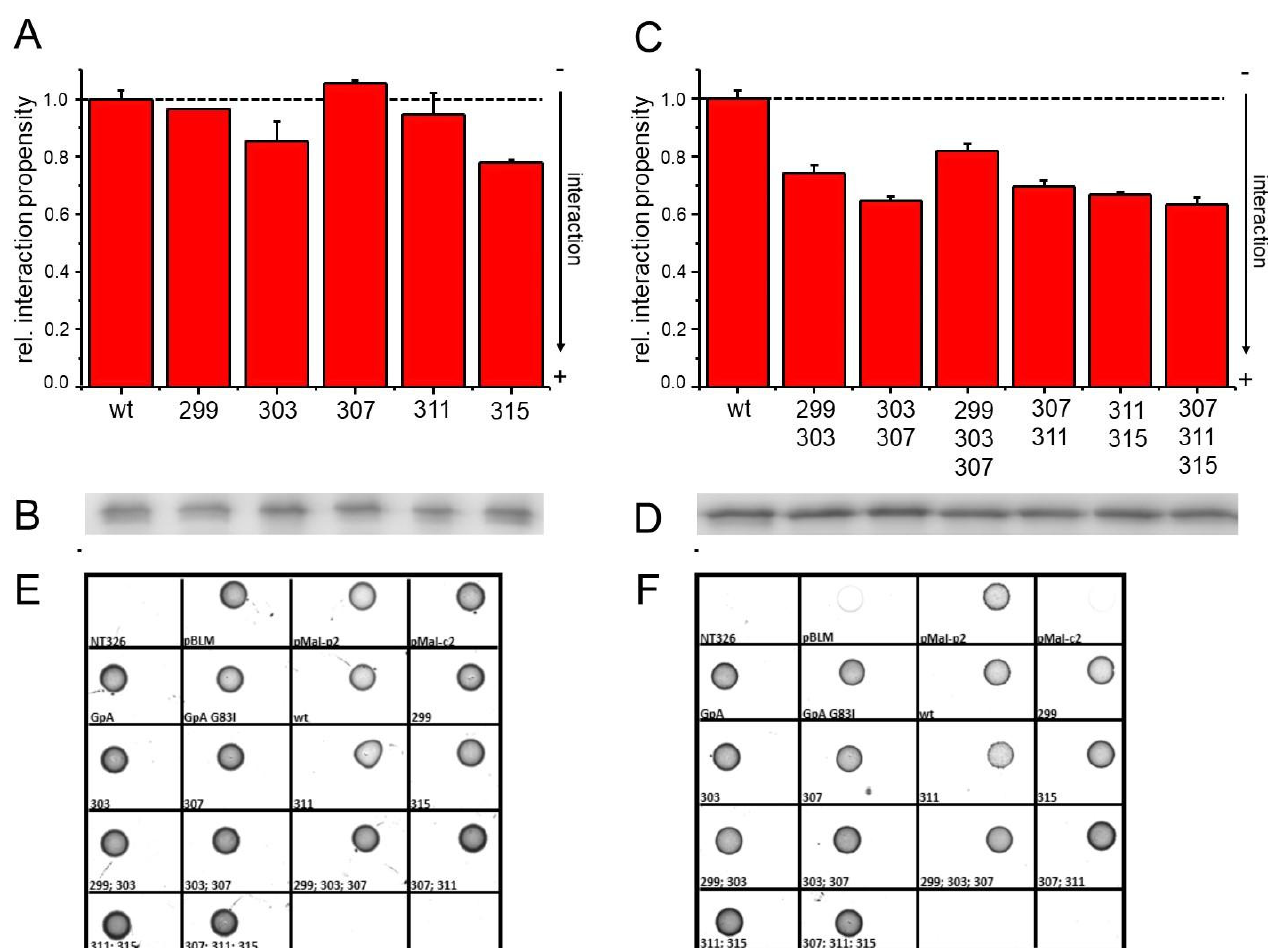
Figure 2. GALLEX measurements of the human CA XII TM domain mutants. ( A ) Interaction tendencies of CA XII TM variants carrying mutations of individual small amino acids to Ile. The position of the mutated amino acid is indicated below each bar. All interaction propensities have been normalized to the wt (set as 1.0). The interaction propensities are an average of three independent measurements, and the standard deviation is shown. ( B ) Identical amounts of isolated total membrane proteins of cells analyzed in ( A ) were separated via SDS-PAGE, and the expressed amount of the CA XII TM fusion protein was analyzed via Western blot analyses using an antibody directed against the MalE protein. All analyzed proteins were expressed at similar levels in membranes. ( C ) GALLEX measurement of CA XII variants carrying mutations of multiple small amino acids to Ile. All interaction propensities have been normalized to the wt (set as 1.0). The interaction propensities are an average of three independent measurements, and the standard deviation is shown. ( D ) Identical amounts of isolated total membrane proteins of cells analyzed in ( C ) were separated in an SDS gel, and the expressed amount of the Ca XII TM fusion protein was analyzed via Western blot analyses using an antibody directed against the MalE protein. All analyzed proteins were expressed at similar levels in membranes. ( E , F ) Maltose complementation assay to determine the TM topology of the analyzed chimeric proteins. The correct topology of the analyzed chimeric proteins within the E. coli membrane was tested using a maltose complementation assay. MalE-deficient E. coli NT326 cells carrying different plasmids are able to grow on M9-agar plates containing glucose as the sole carbon source ( E ), but only grow on maltose plates ( F ) if the construct is correctly oriented in the membrane and the MalE domain is located in the E. coli periplasm. The plates contained 100 µg/ml ampicillin and a final concentration of 100 µM IPTG. On both plates, growth of NT326 cells, which have not been transformed with a plasmid, is not seen. Cells containing the empty pBLM plasmid and cells carrying the pMal-c2 plasmid (which leads to a cytoplasmic localization of the MalE domain) are unable to grow on maltose plates. Growth of all used GALLEX constructs on maltose-only plates confirms membrane insertion and a correct TM orientation of the CA XII TM domains.